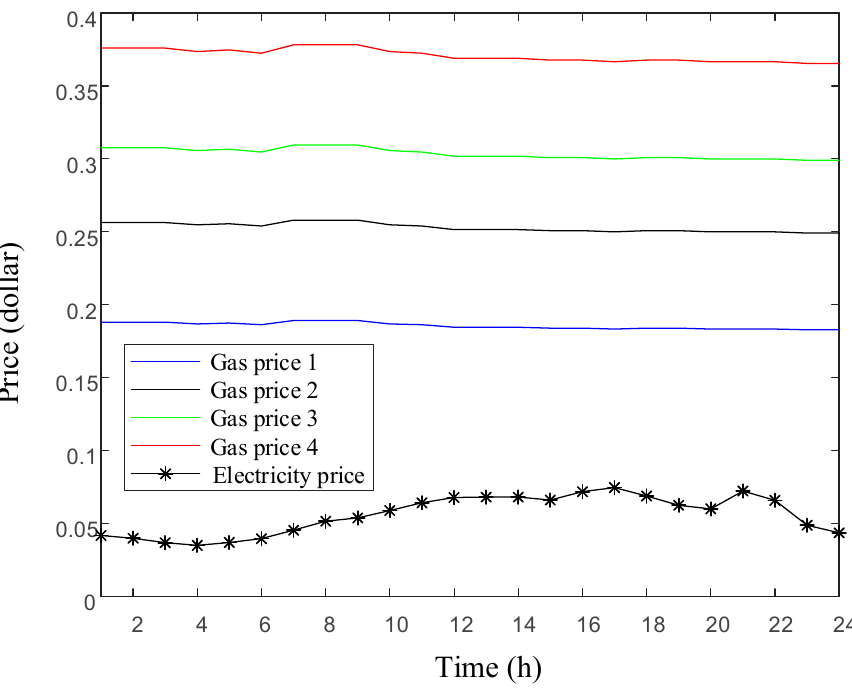
Figure 14. Different gas prices and electricity price in stage 3, typical day 2.